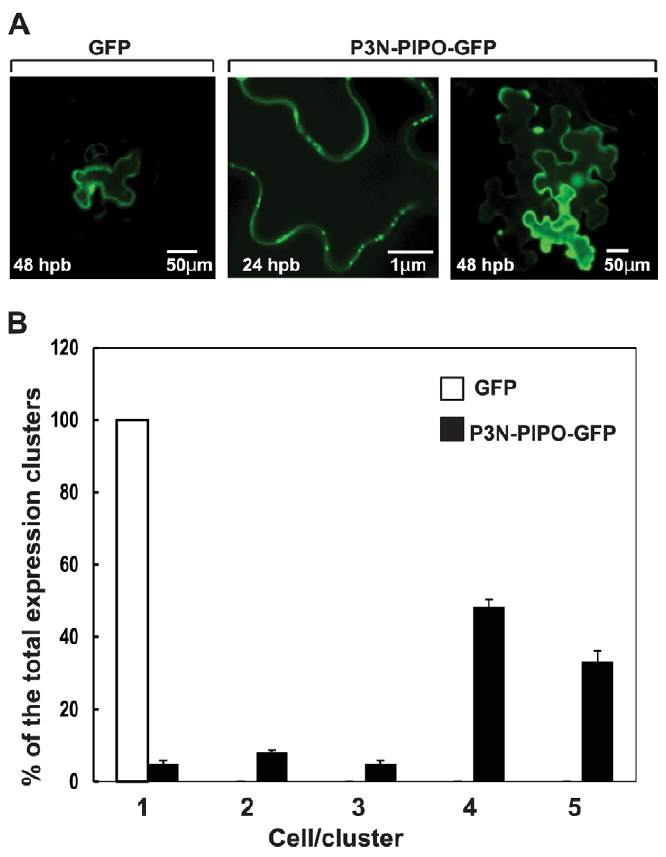
Figure 2. Cell-to-cell movement of P3N-PIPO-GFP in N.benthamiana leaves. (A) Images of epidermal cells expressing GFP alone or fused to P3N-PIPO (P3N-PIPO-GFP) at indicated hours post biolistic bombardment (hpb). Images are projections of single confocal section. (B) Quantification of cell-to-cell movement of GFP and P3N-PIPO-GFP. At least 160 GFP-expressing clusters in each bombarded sample were analyzed at 24 hpb and 48 hpb. At 48 hpb the number of cells in each cluster was counted, followed by statistical evaluation by the unpaired Student’s t -test (P=0.151). Error bars represent standard deviations.